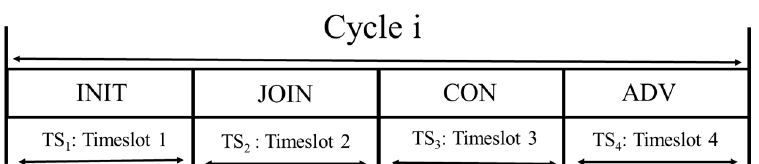
Figure 2. Four timeslots in each cycle in the network construction period of the minimized latency Multi-hop LoRa network.